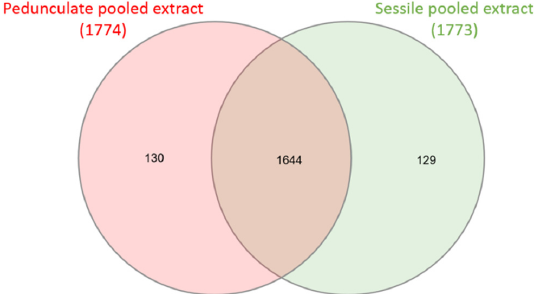
Figure 1. Venn diagram of sessile pooled extracts (21 samples) and pedunculate pooled extracts (21 samples). Numbers above species represent total precursor ions detected in each pooled extract. The circle overlap represents common ions, and the non-overlapping part represents specific ions.